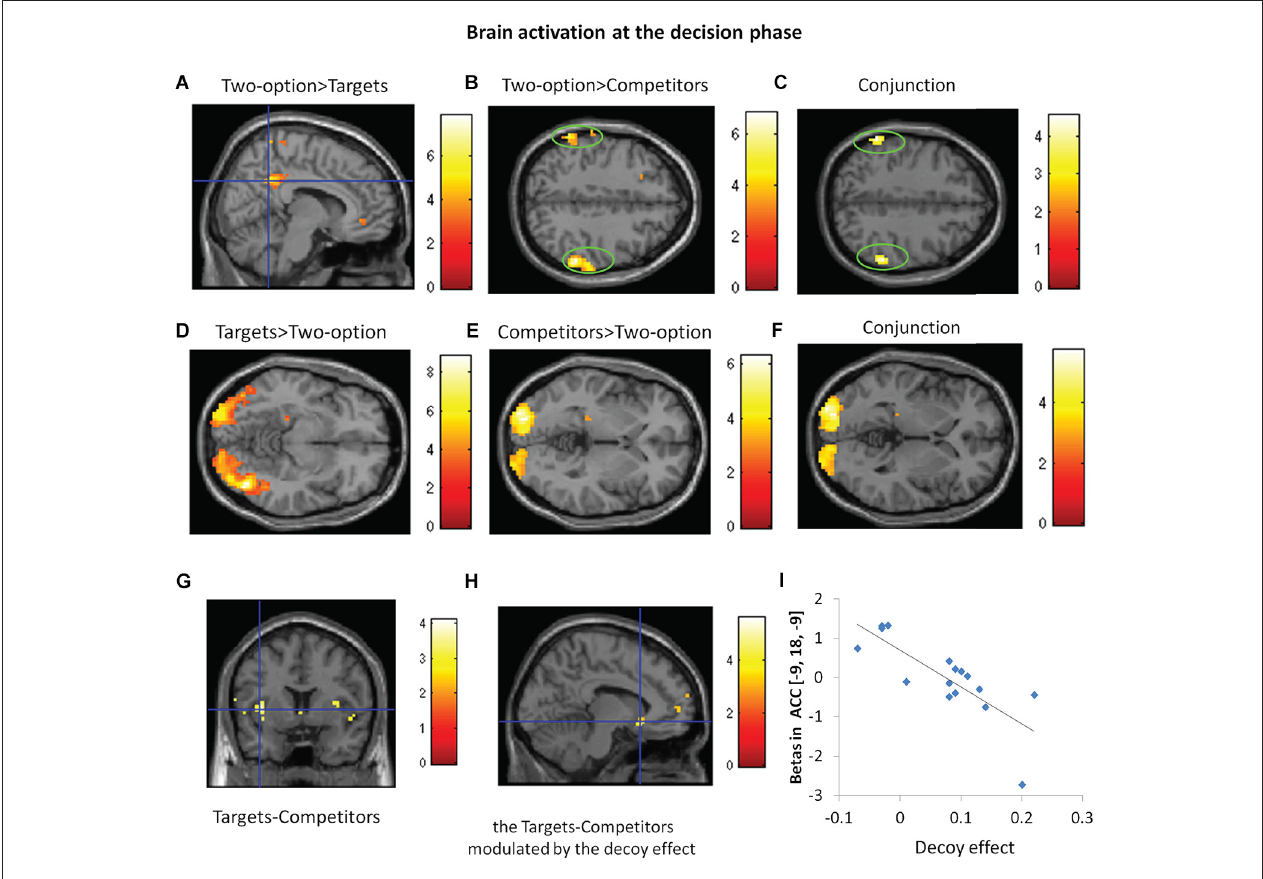
vs. two-option (F) . (G) Regions with significant activation for targets vs. competitors. (H) Regions showing correlation between the decoy effect and ACC activation in the contrast of targets vs. competitors. (I) The correlation between decoy effect and parameter estimates of ACC activation for target-competitor contrast at a peak voxel ( x = − 9, y = 18, z = −